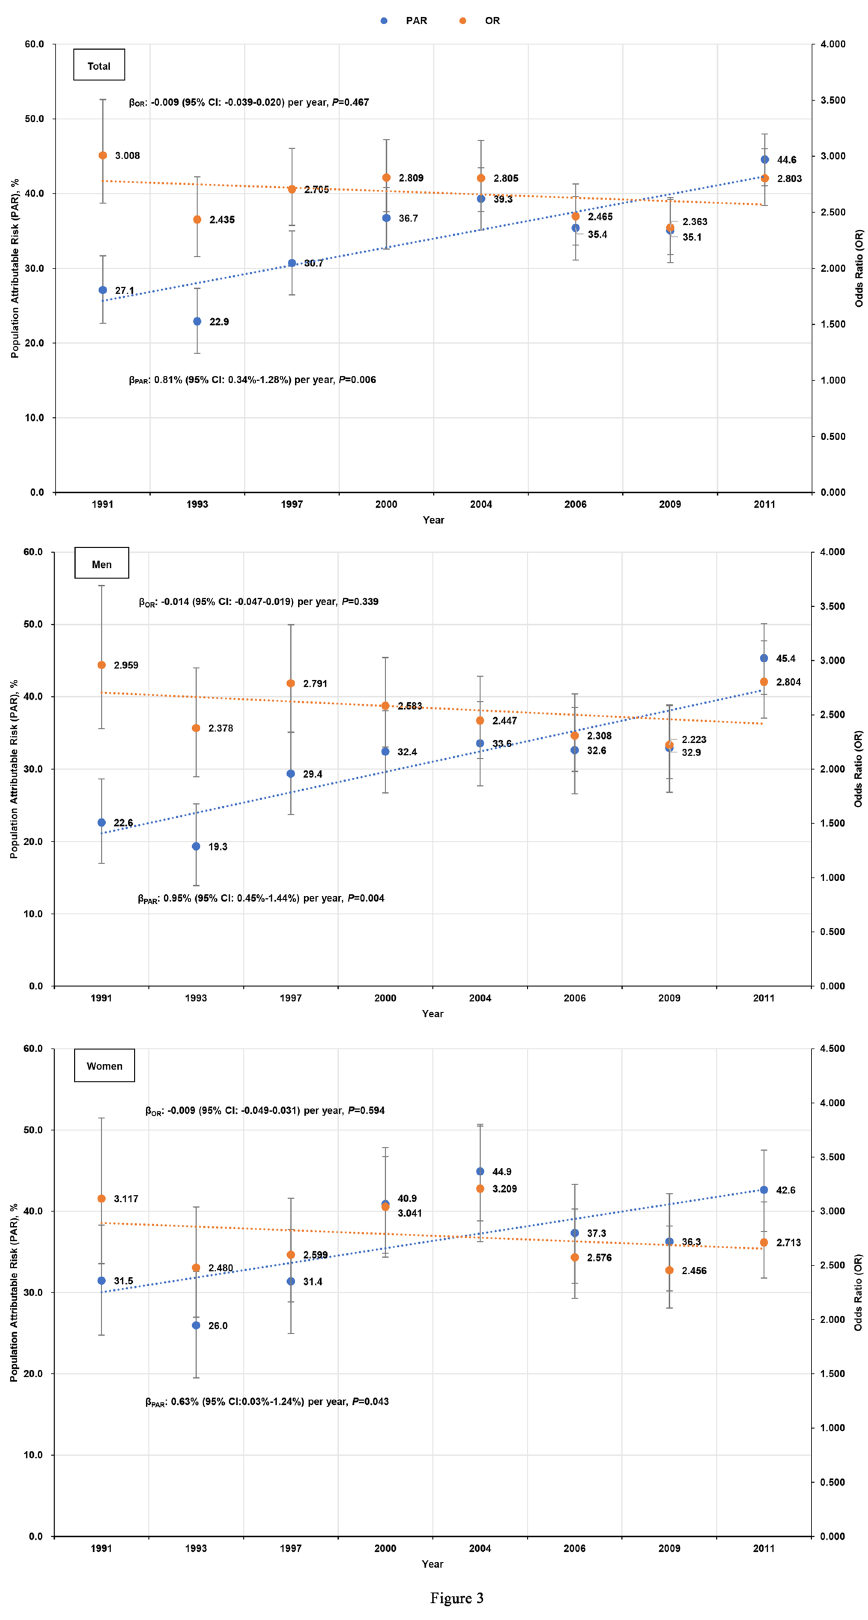
Figure 3. Secular trends in ORs (95% CIs) for hypertension in overweight/obese participants compared with normal weight participants. The ORs were adjusted for age, current smoking, and current alcohol consumption. Secular trends in PAR (95% CIs) of hypertension because of